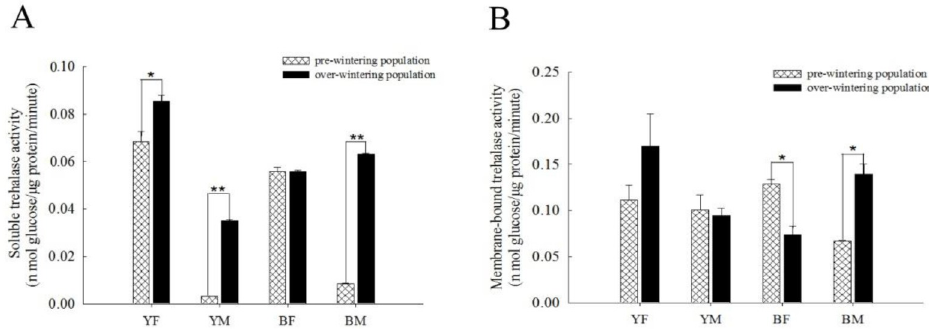
Fig 4. Comparison of changes in activity of two types of trehalase between pre-wintering and over-wintering H . axyridis individuals in females and males of different colour forms. (A) Changes in soluble trehalase, and (B) changes in membrane-bound trehalase in pre-wintering and over-wintering yellow females (YF), yellow males (YM), black females (BF) and black males (BM). Each bar depicts the mean (+ SD) of three samples. Trehalase activity at the stage of pre-wintering was used as a control. Asterisks show significant differences between pre-wintering and over- wintering individuals in the same group (Tukey’s test, �� P < 0.01; � P <